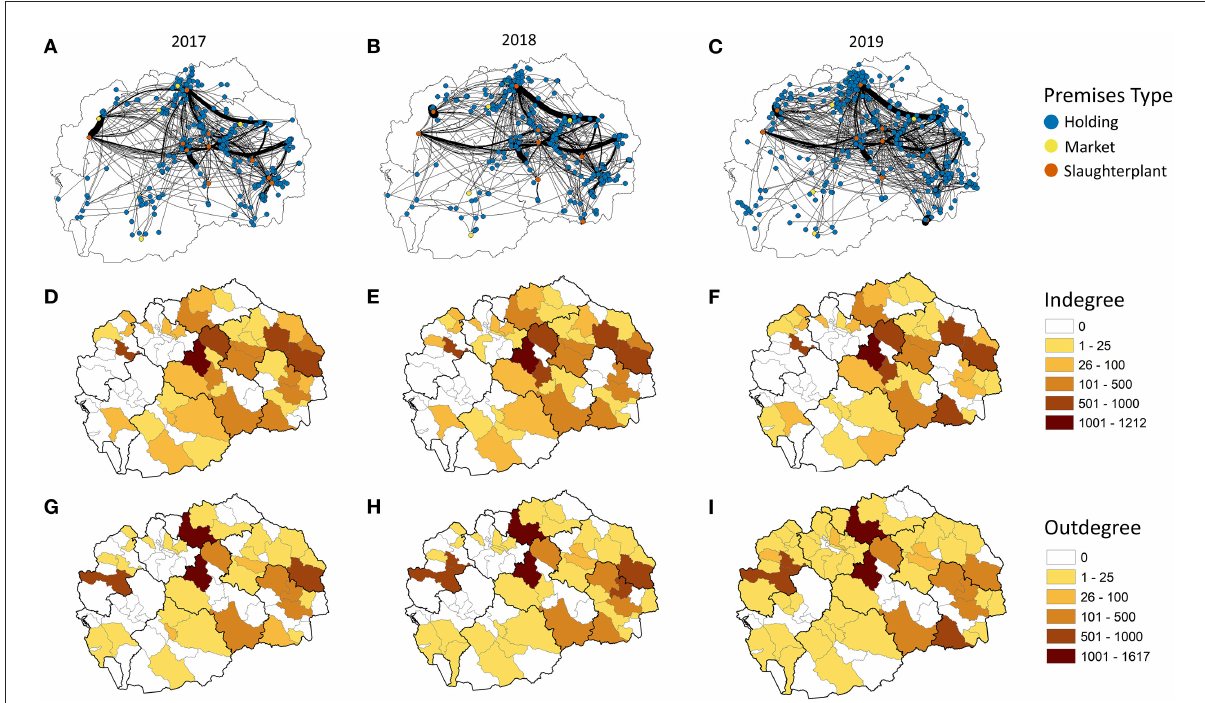
FIGURE3 Network analysis of live pig movements in North Macedonia for 2017–2019. Simplified network with edge weight as the number of movements divided by 20 for (A) 2017, (B) 2018, (C) 2019. Summary of the number of live pig movements into a municipality for (D) 2017, (E) 2018, (F) 2019. Summary of the number of live pig movements out of a municipality for (G) 2017, (H) 2018, (I) 2019.